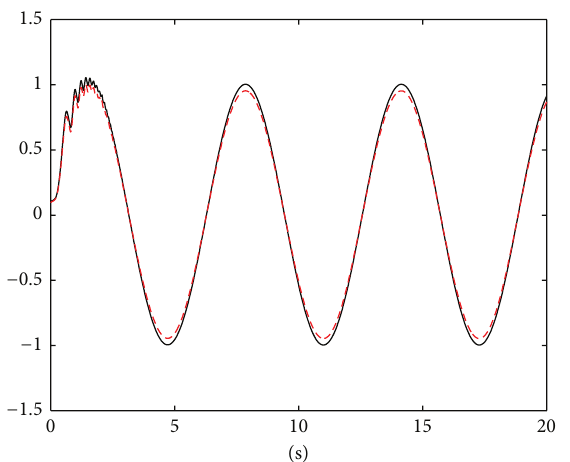
Figure 2: The curves of 𝑥 1 (solid) and its estimation ̂𝑥 1 (dash).